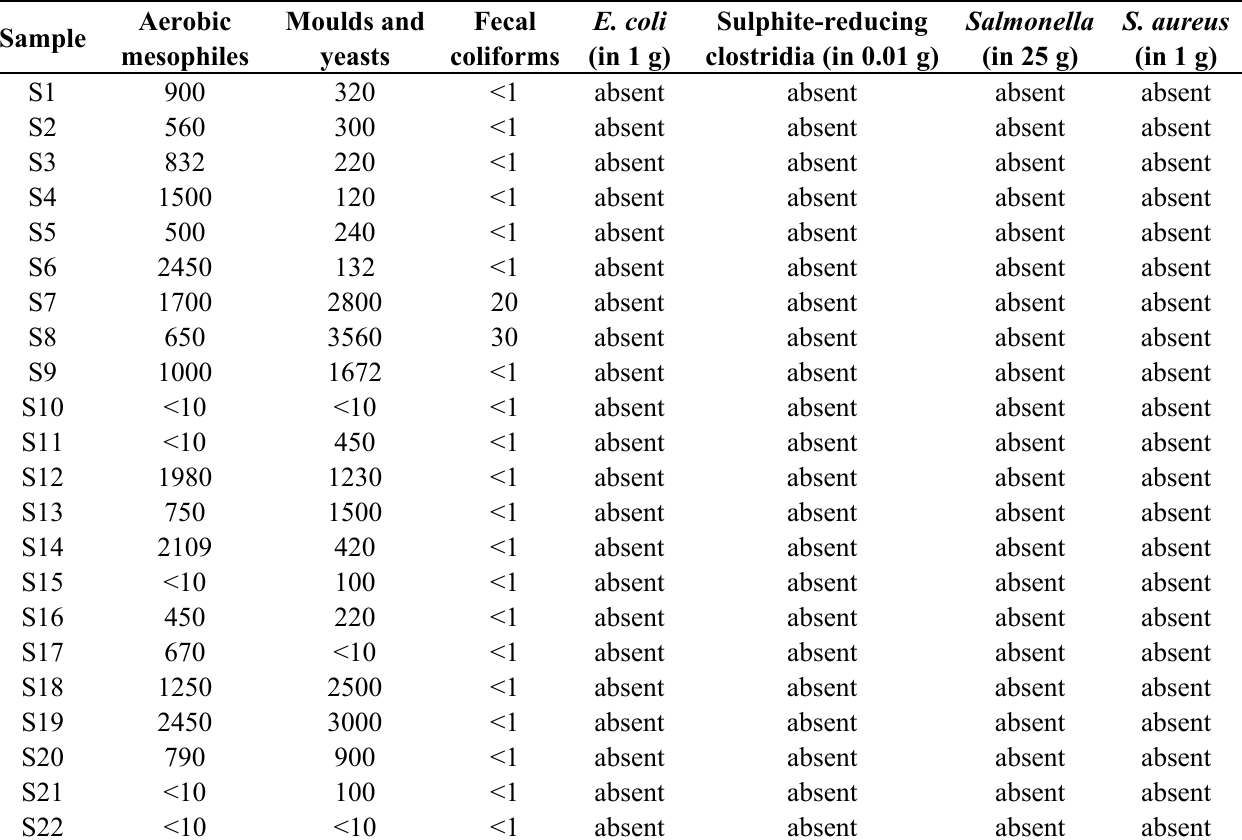
Table 5. Microbial analyses of the organic apian